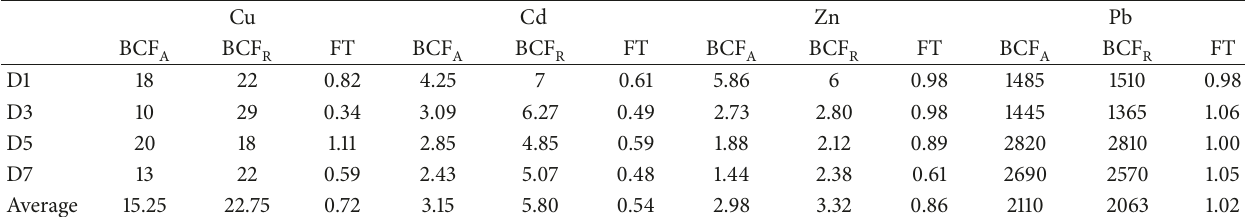
Table 2: Translocation and bioaccumulation factor of metals in the leaf and root of Typha latifolia [52].